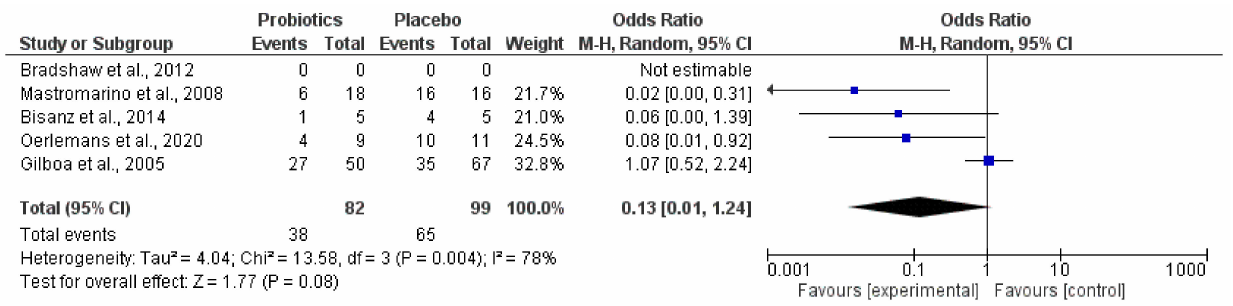
Figure 6. Effect of vaginal probiotics for modulation increase in Lactobacillus